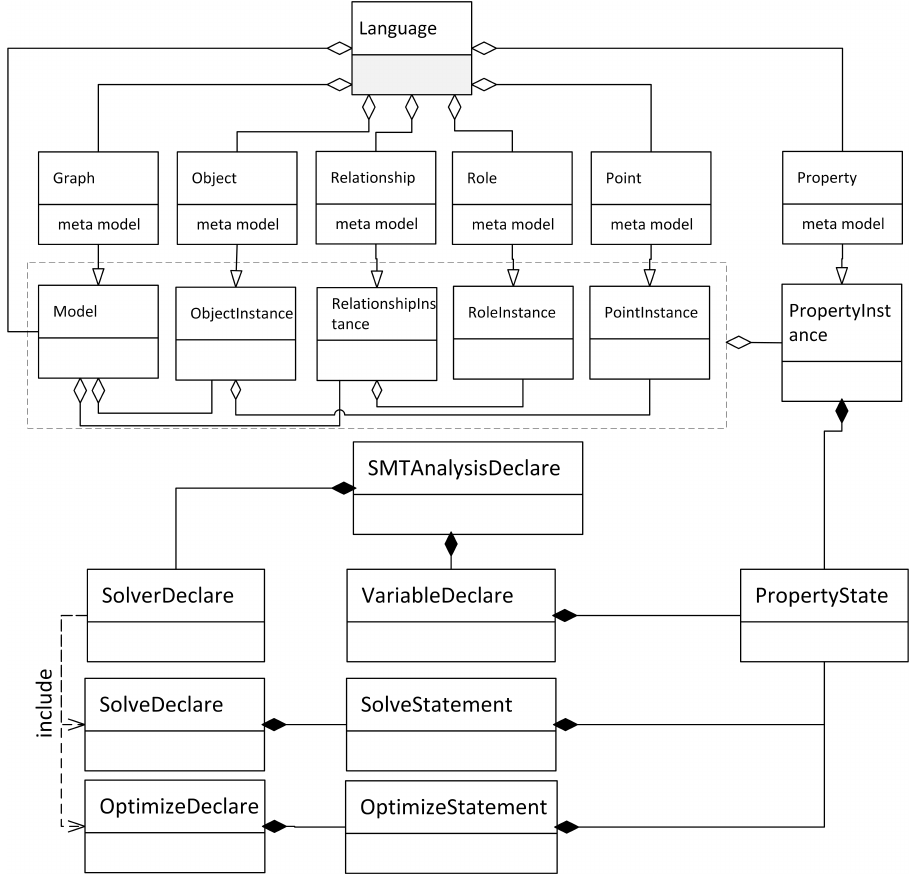
Figure 4. Data structure tree of the extended KARMA language for static